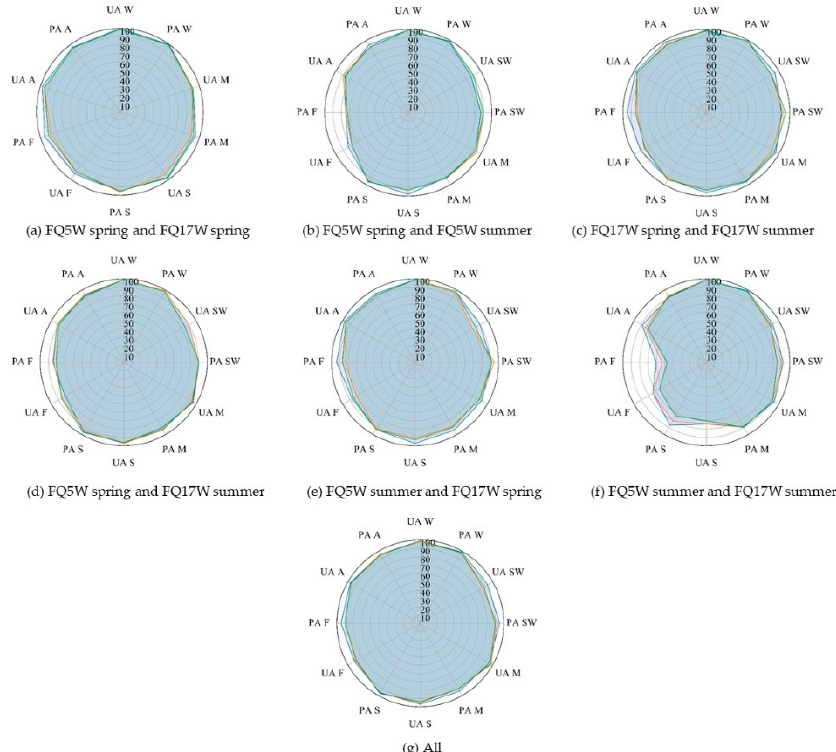
Figure 12. User’s (UA) and producer’s (PA) accuracies for water (W), shallow water (SW), marsh (M), swamp (S), forest (F), and agriculture/non-forested (A) for models based on multi-angle/multi-temporal QP (blue), CP medium (orange), or CP high resolution (green) images for classifications using ( a ) spring images collected at steep and shallow incidence angles, ( b ) spring and summer images collected at steep incidence angle, ( c ) spring and summer images collected at shallow incidence angle, ( d ), spring image collected at steep incidence angle and summer image collected at shallow incidence angle, ( e ) spring image collected at shallow incidence angle and summer image collected at steep incidence angle, ( f ) summer images collected at steep and shallow incidence angles, and ( g ) all images.